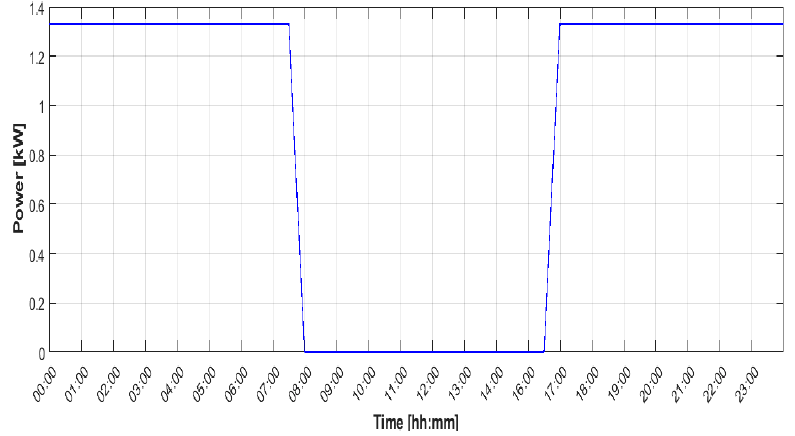
Figure 3. Load curve of the lighting system.